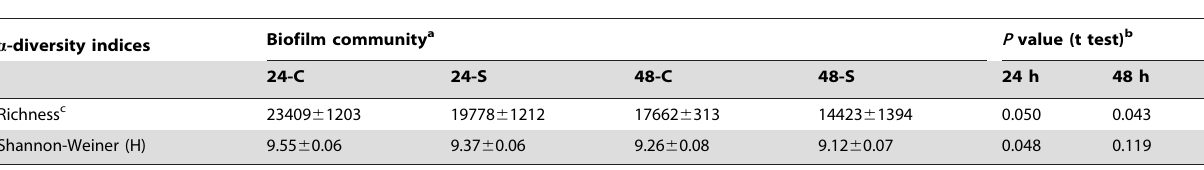
Table 1. The impact of EcO157 on biofilm community a -diversity.